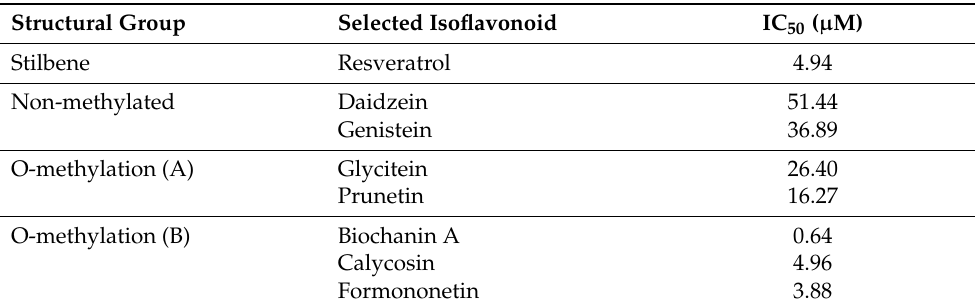
Table 2. In vitro determined IC 50 values for firefly luciferase inhibition for the positive control (resveratrol) and the 11 selected isoflavonoids, according to their structural grouping (Figure 1). Structural